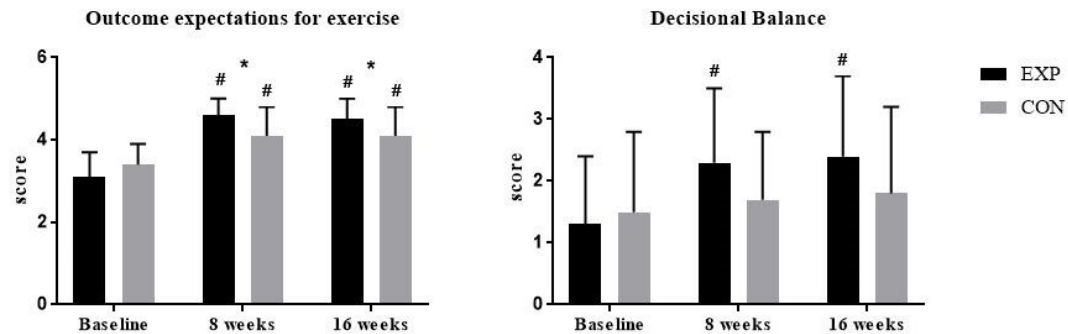
Figure 3. Within-group and between-group changes in questionaire scores. Abbreviations: EXP, experimental group; CON, control group. # p < 0.05 within-group change compared to baseline; * p < 0.05 for between-group di ff erence at specific time points. Table 4. Results in outcome expectations for exercise and decisional balance with e ff ect